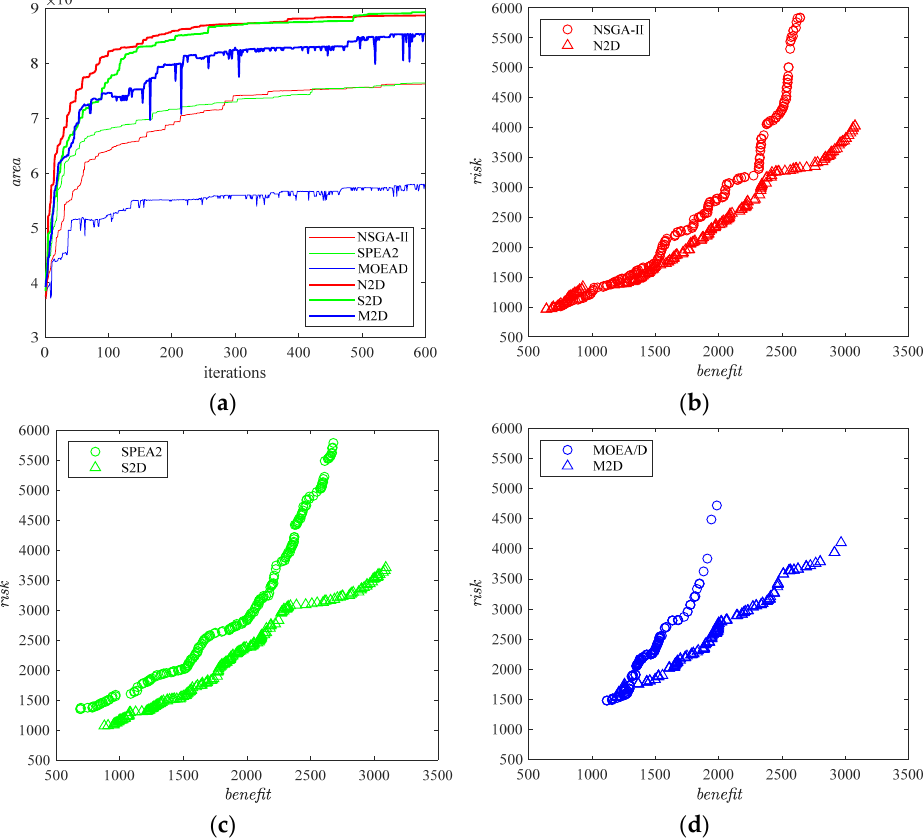
Figure 5. A simulation of case 1 as an example to show the convergence speed of the algorithms and the distribution of the solution sets (Task scheduling information and initial population settings were consistent). ( a ) The convergence speed of the algorithms; ( b ) The distribution of the sets solved by NSGA-II and N2D; ( c ) The distribution of the sets solved by SPEA2 and S2D; ( d ) The distribution of the sets solved by MOEA/D and M2D